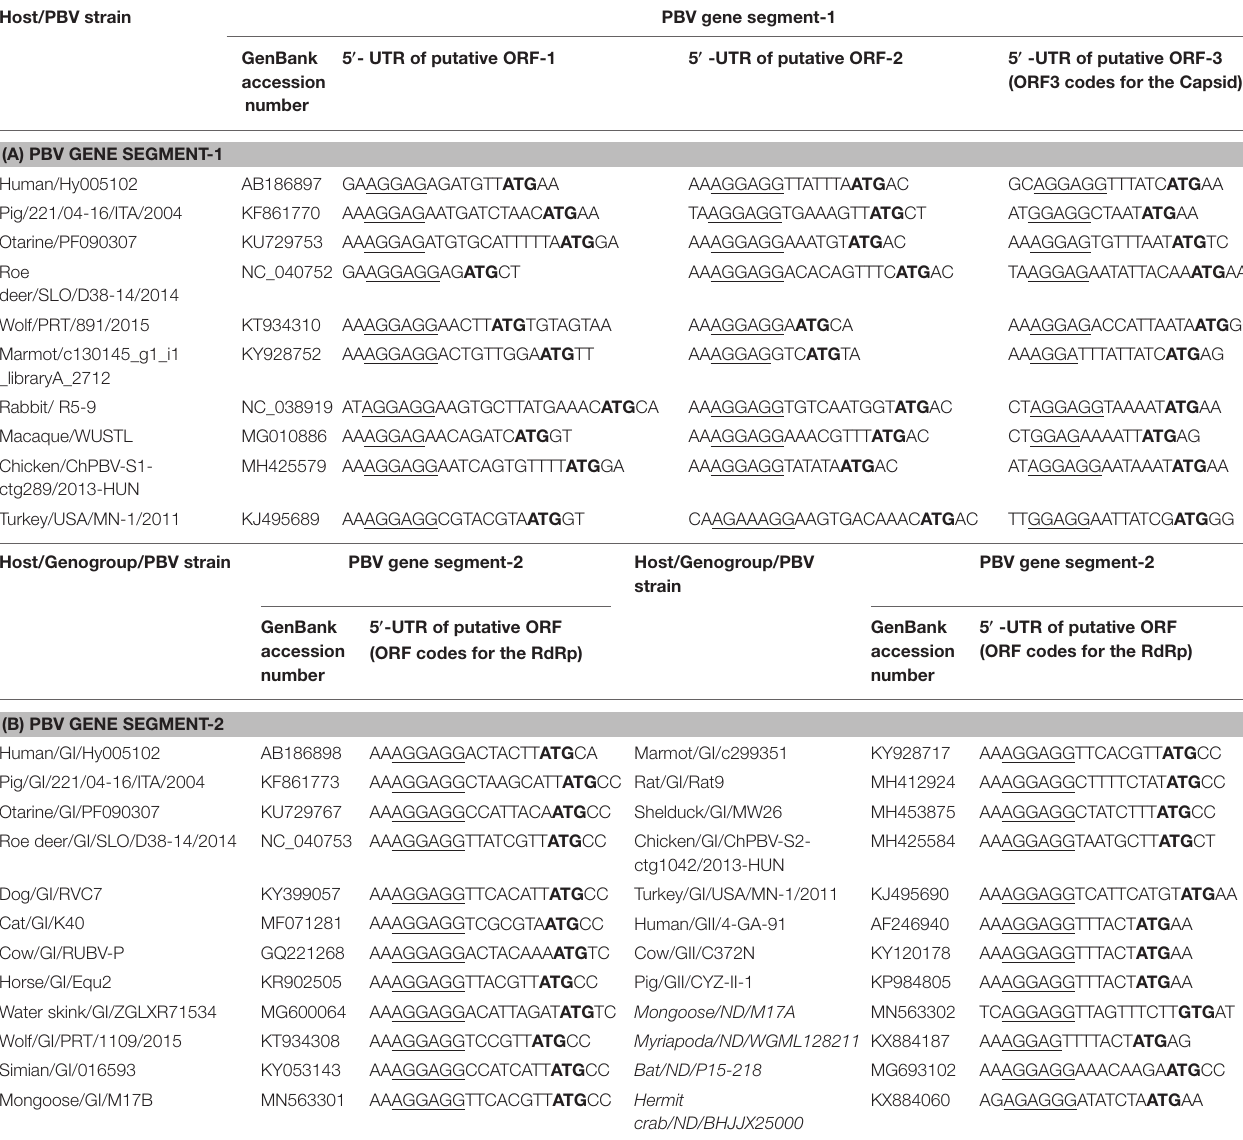
TABLE 1 | The location of the prokaryotic ribosomal binding site (RBS) sequence upstream of the putative open reading frame/s (ORF) in picobirnavirus (PBV) and PBV-like sequences. Host/PBV